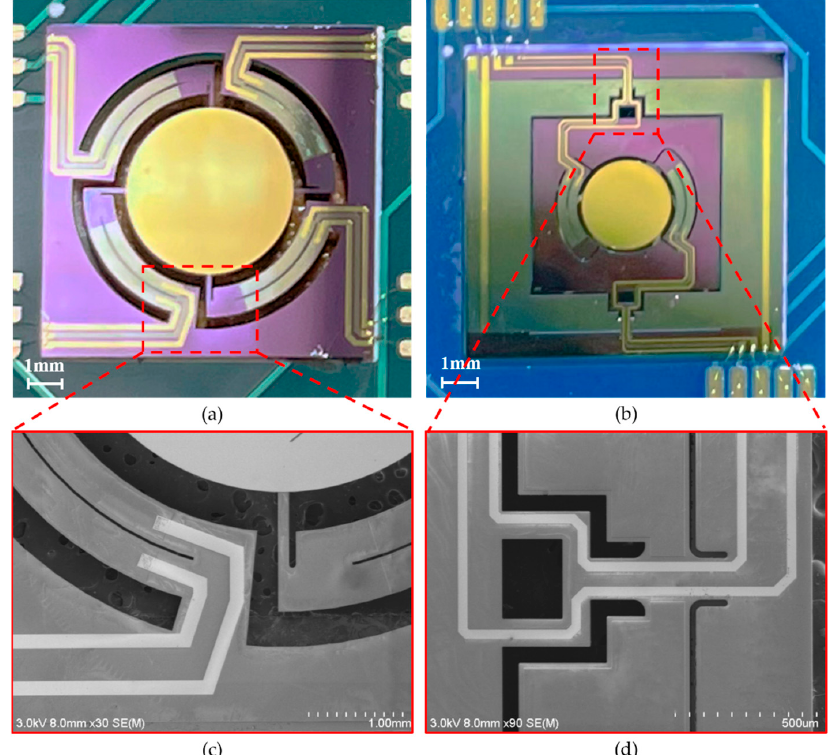
Figure 6. ( a ) Photograph of Design I . ( b ) Photograph of Design II . ( c ) SEM of Design I spring. ( d ) SEM of Design II hinge.